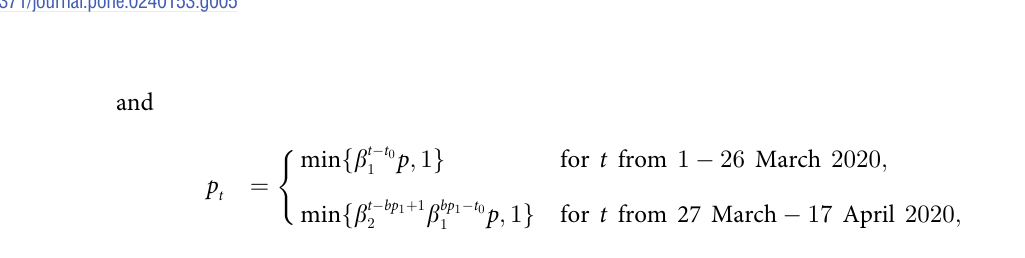
Fig 5. MAPE of predictions vs. size of training data for a range of size of training data (test data) varying from 20 − 25 (6 − 1).